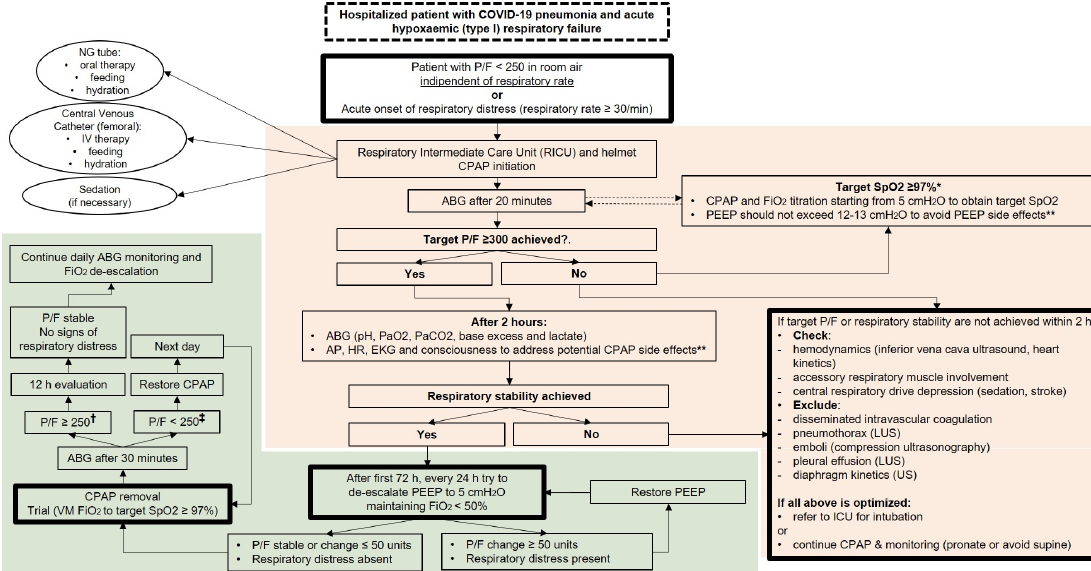
Figure 1. Decisional and monitoring algorithm for continuous positive airway pressure (CPAP) treatment in COVID-19 patients. Flow chart showing a decisional and monitoring algorithm for initiation, titration (red shadowed area), and de-escalation (green shadowed area) of the respiratory support with helmet continuous positive airway pressure (CPAP) in patients admitted with acute hypoxemic respiratory failure secondary to COVID-19 pneumonia. * If patient has metabolic alkalosis. If pH is within physiological limits, SpO 2 target ≥ 95%. ** Cardiac output, O 2 delivery, hyperoxygenation atelectasis, exacerbation of self induced lung injury. Patients at high risk of developing hypercapnic respiratory failure (COPD, emphysema, NMD) should be treated with NIV. † P/F ≥ 200 if patient has COPD or ≥ 70 years old; ‡ P/F < 200 if patient has COPD or ≥ 70 years old. P/F = partial pressure of oxygen to inspired oxygen fraction ratio; ABG = arterial blood gas analysis; AP = arterial pressure; EKG = electrocardiogram; FiO 2 = inspired oxygen fraction; HR = heart rate; ICU = intensive care unit; IV = in vein; LUS = lung ultrasound; NG = nasogastric; PEEP = positive end expiratory pressure; P/F = partial pressure of oxygen to inspired oxygen fraction ratio; US = ultrasound; VM = Venturi Mask; PaO 2 = partial arterial pressure of oxygen; SpO 2 = peripheral O 2 saturation; COPD = Chronic Obstructive Pulmonary Disease; PaCO 2 = partial arterial pressure of carbon dioxide; NMD = neuromuscular disease; NIV = non-invasive ventilation.